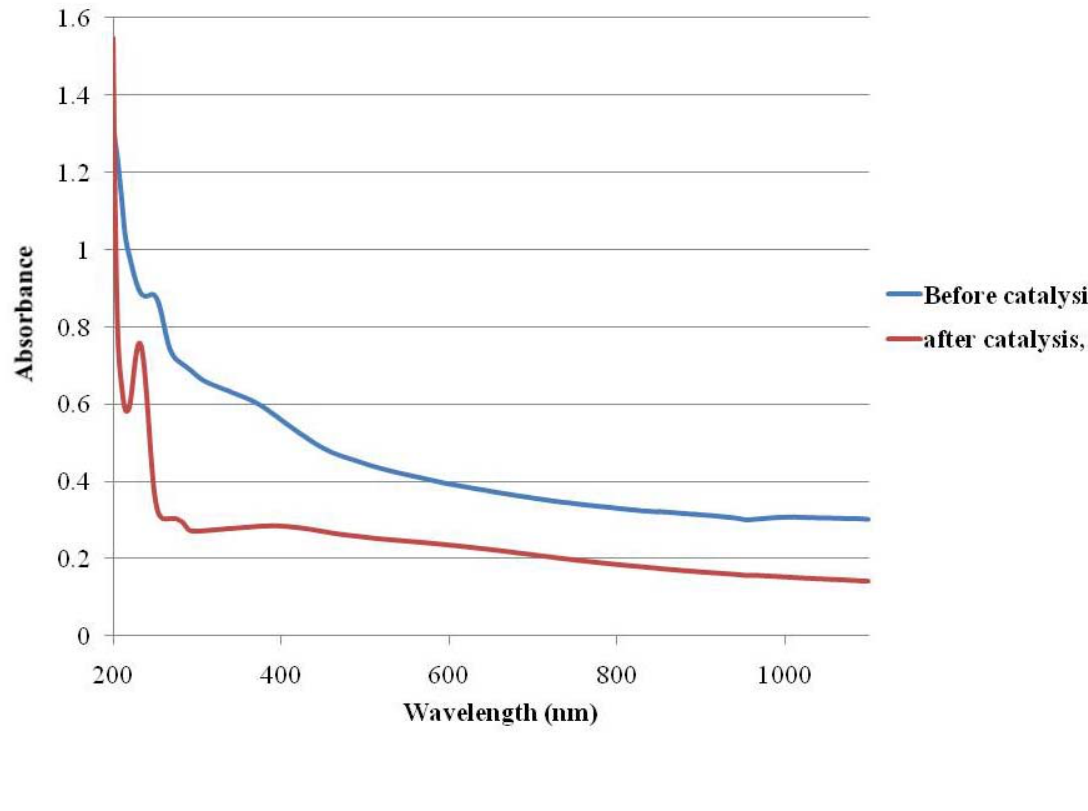
Figure 4. UV-Vis Spectra for Fe alcohol oxidation, conducted at